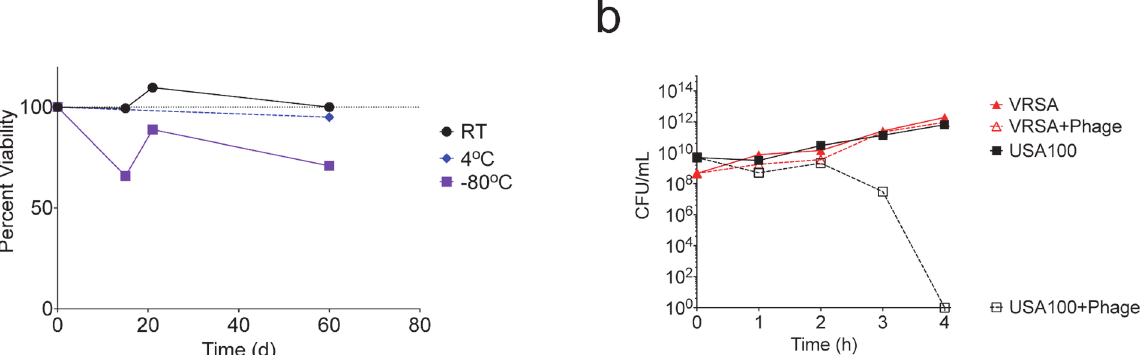
Fig 6. SATA-8505 Exhibits Commercial Viability but Significant Strain Limitations. (a) SATA-8505 quantified over up to sixty days after storage at either room temperature (RT), 4 degrees Celsius (4 ° C), or frozen at -80 ° C. (b) Average hourly quantification of 10 8 – 10 9 CFU of USA100 S . aureus or a vancomycin resistant variant of USA100 (VRSA) cultured with up to 10 11 PFU of SATA-8505. Data shown are a representative of 2 independent